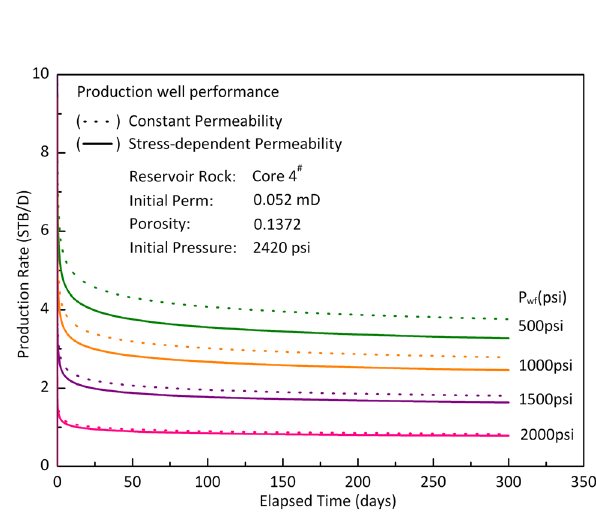
Fig. 4 Production rates under different producing pressures